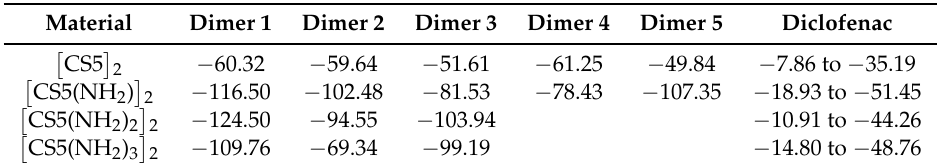
Table 4. Supermolecularinteractionenergies[kcal/mol]forchitosandimerscalculatedwithB97-D3/6-31G(d,p) approach in vacuum. For comparison, the ranges of diclofenac–material interaction energies from Table 3 are given in the last